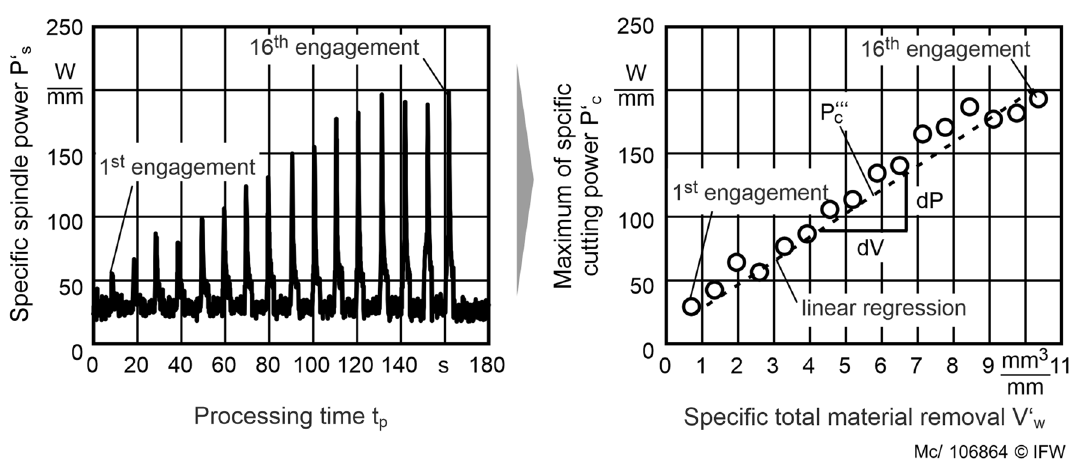
Figure 5. Methodology for determining the volume-specific cutting